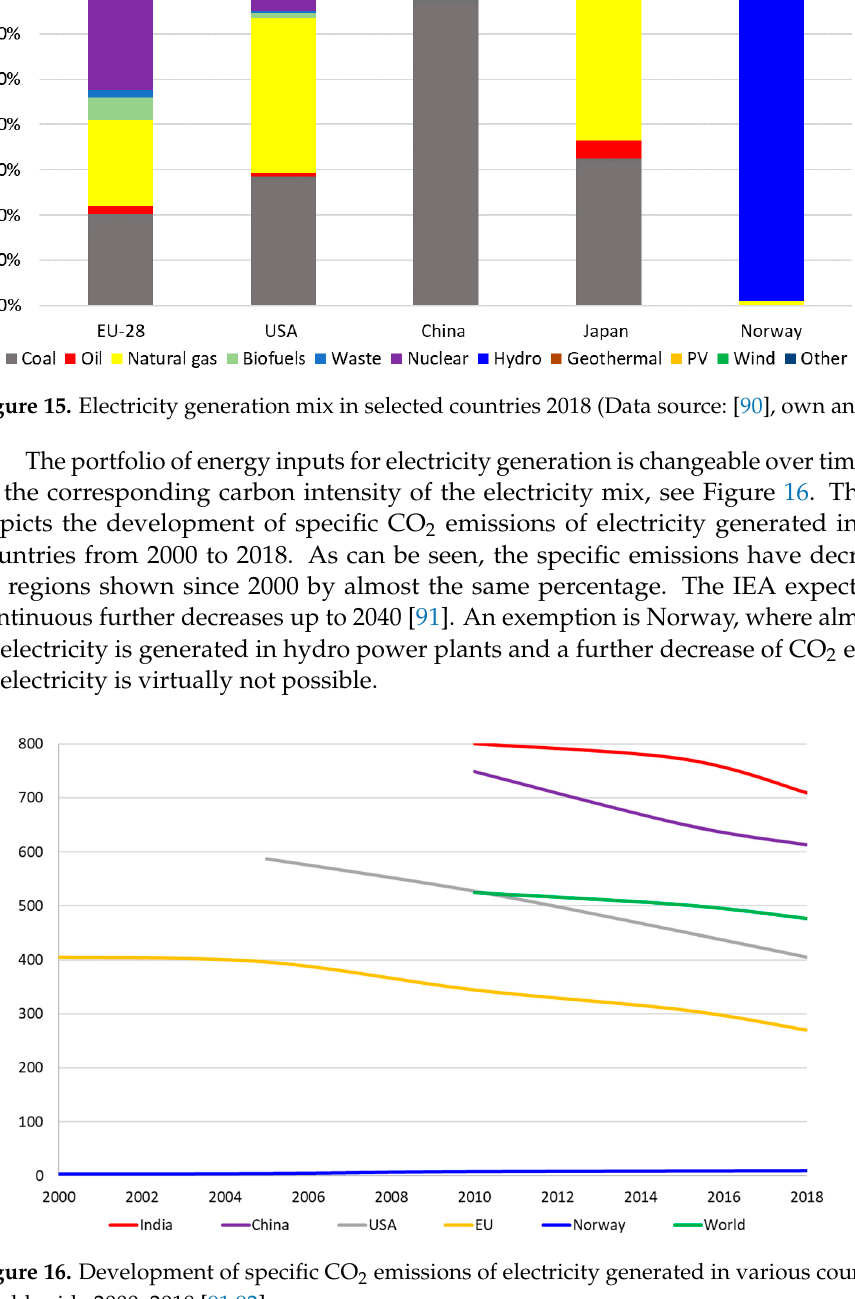
Figure 17. Specific CO 2 emissions of electricity generated in various countries compared to gaso- line and diesel.